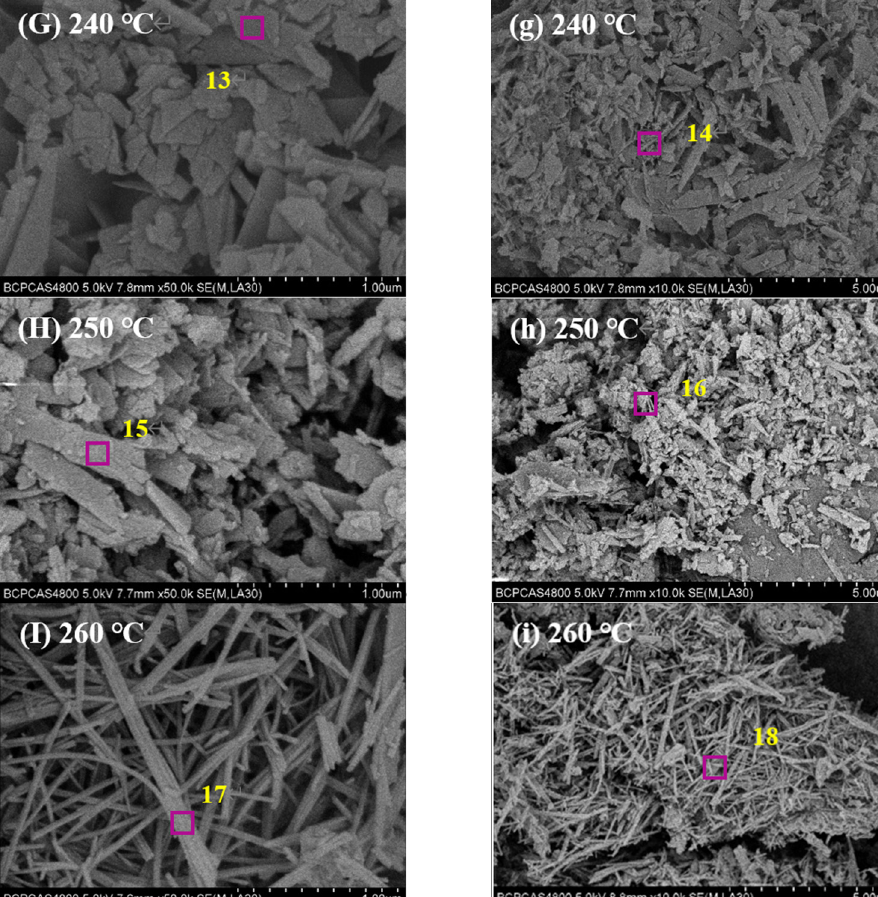
Figure 3. SEM images of synthesis products under different hydrothermal synthesis temperature; the uppercase letters represent SEM images of 50,000 times while the lowercase letters represent SEM images of 10,000 times.